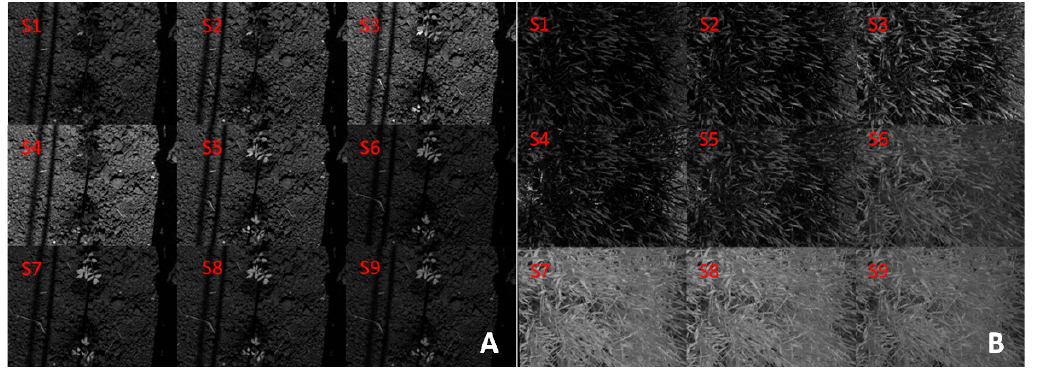
Figure 15. Output of the 9 sensors of the MAIA spectral camera on tomato plants ( A ), durum wheat ( B ).